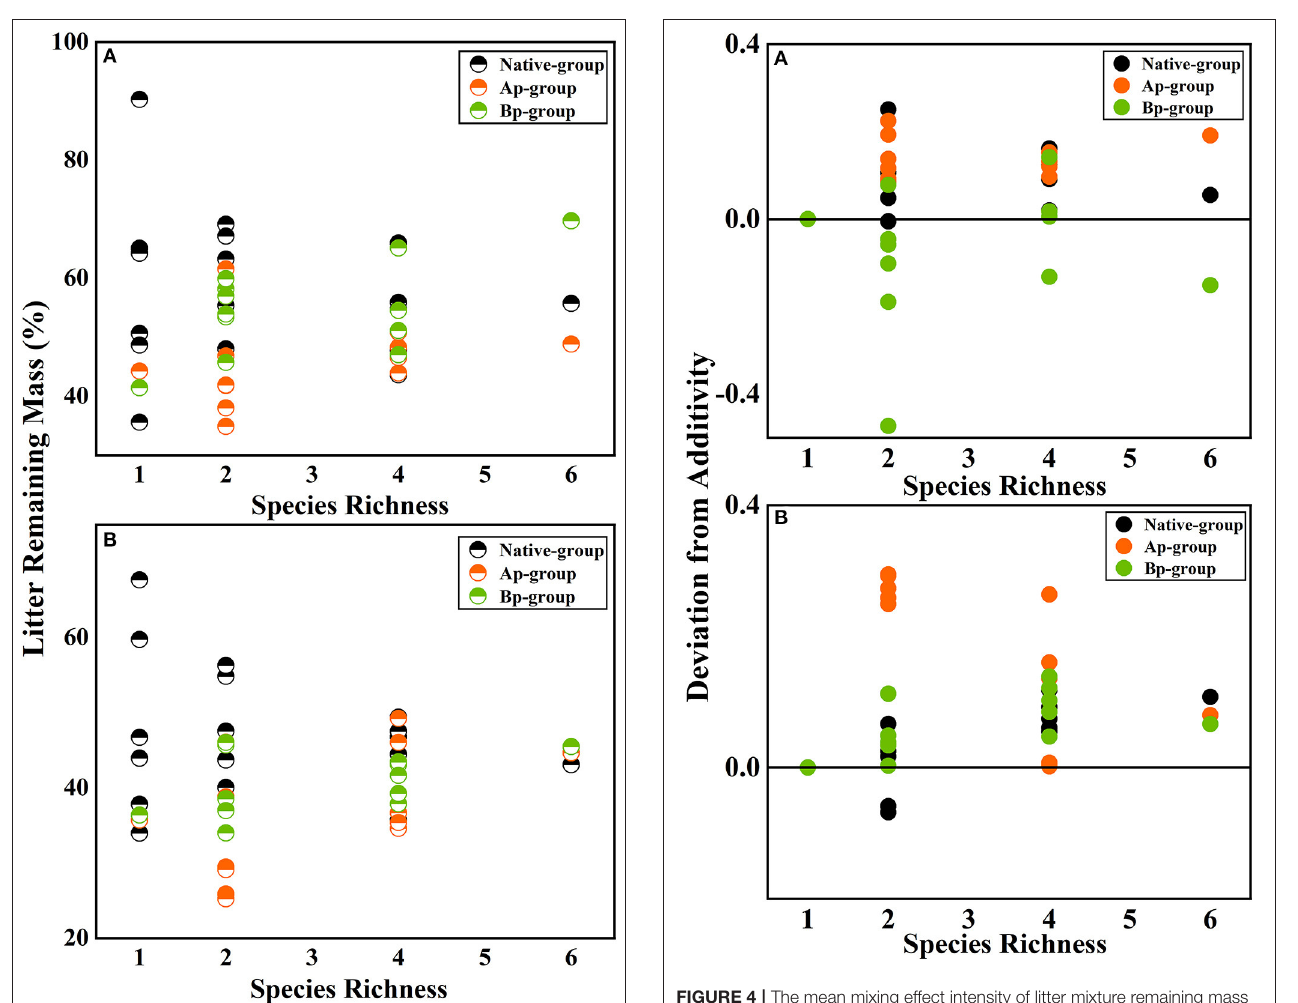
FIGURE 4 | The mean mixing effect intensity of litter mixture remaining mass on different species richness in the hydro-fluctuation zone (A) and terrestrial zone (B) . The Ap-group indicates litter mixtures of A. philoxeroides and native species, and the Bp-group represents litter mixtures of B. pilosa and native species. Data are expressed as mean values. In the mean mixing effect intensity values, values above 0 indicate synergistic effects, and values below 0 indicate inhibitory